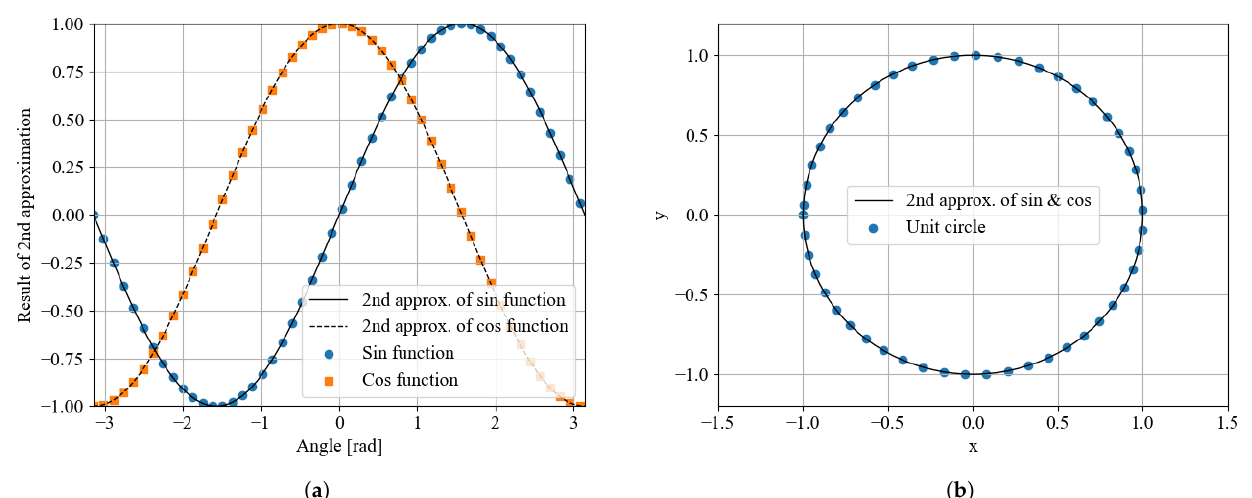
Figure 3. Summary of 2nd approximations of sin-function and cos-function. ( a ) Second approxima- tion of sin and cos functions by RCM. ( b ) Comparison with unit